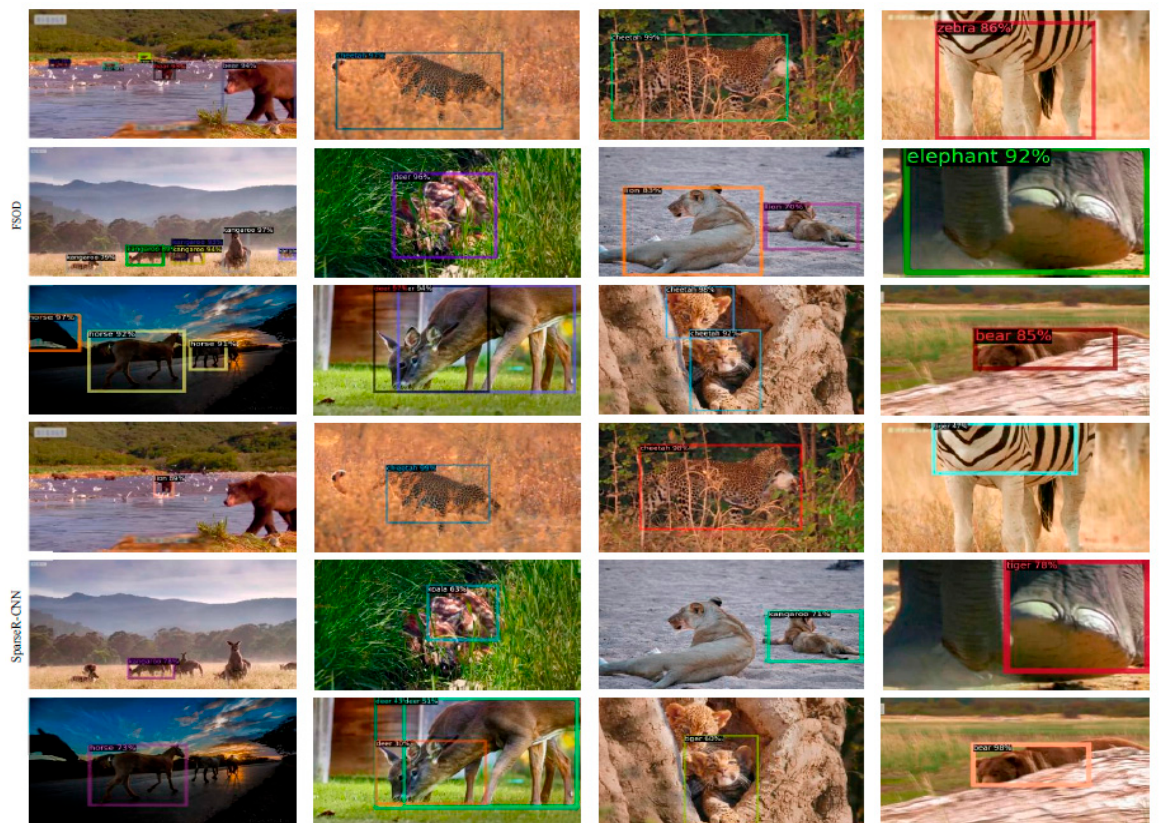
Figure 9. Challenging example image results for the proposed method and Sparse R-CNN method. First column: multiple animals; second column: occluded or overlapped; third column: camouflaged; fourth column: incomplete body.